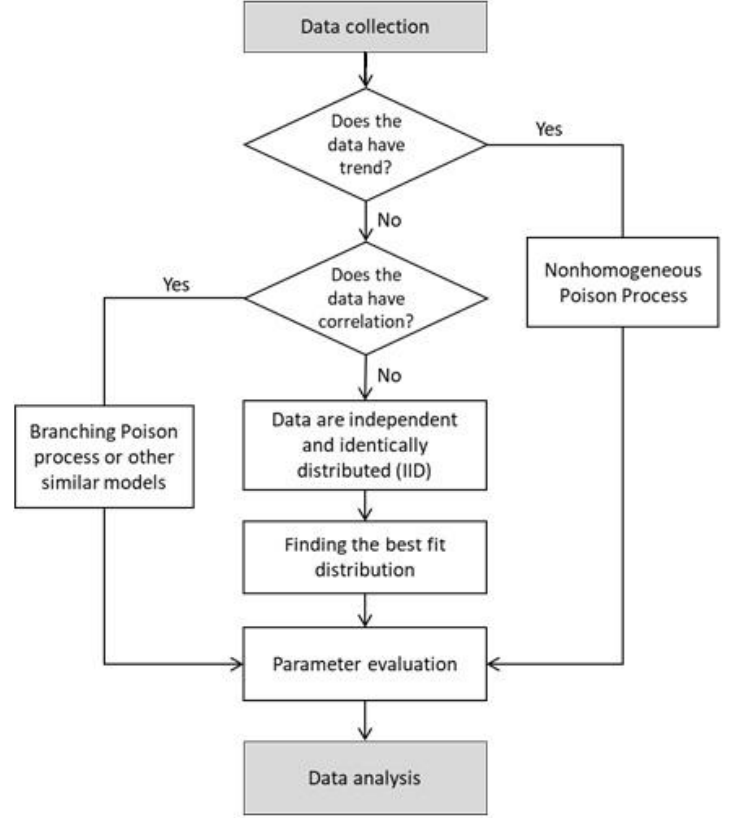
Figure 4. The process of data analysis.